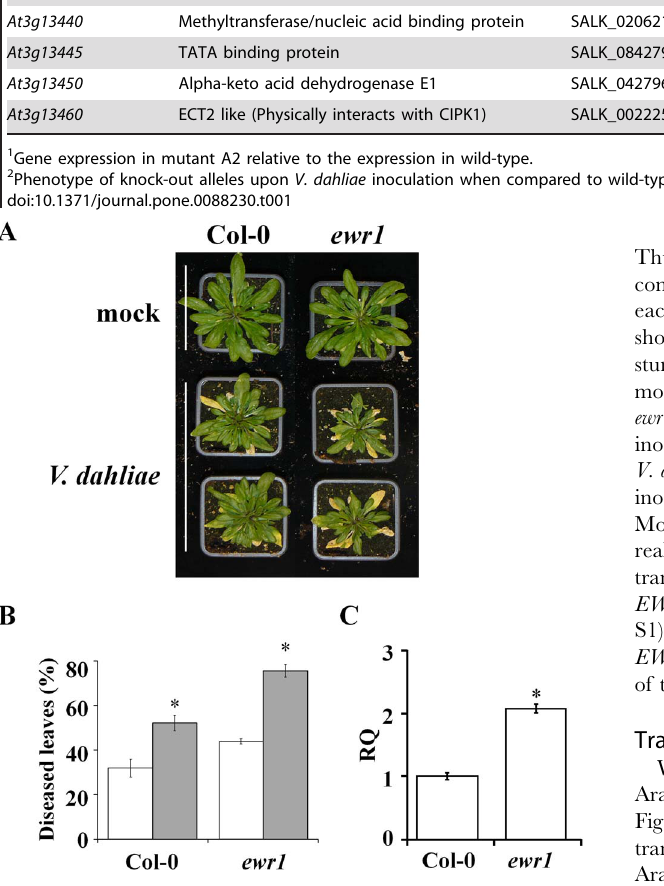
Figure 2. Deletion of EWR1 enhances Arabidopsis susceptibility to Verticillium wilt. (A) Typical symptoms of V. dahliae on the wild- type (Col-0) and EWR1 knock out ( ewr1 ) plants. Picture was taken at 21 days post inoculation (dpi) and a representative of three independent